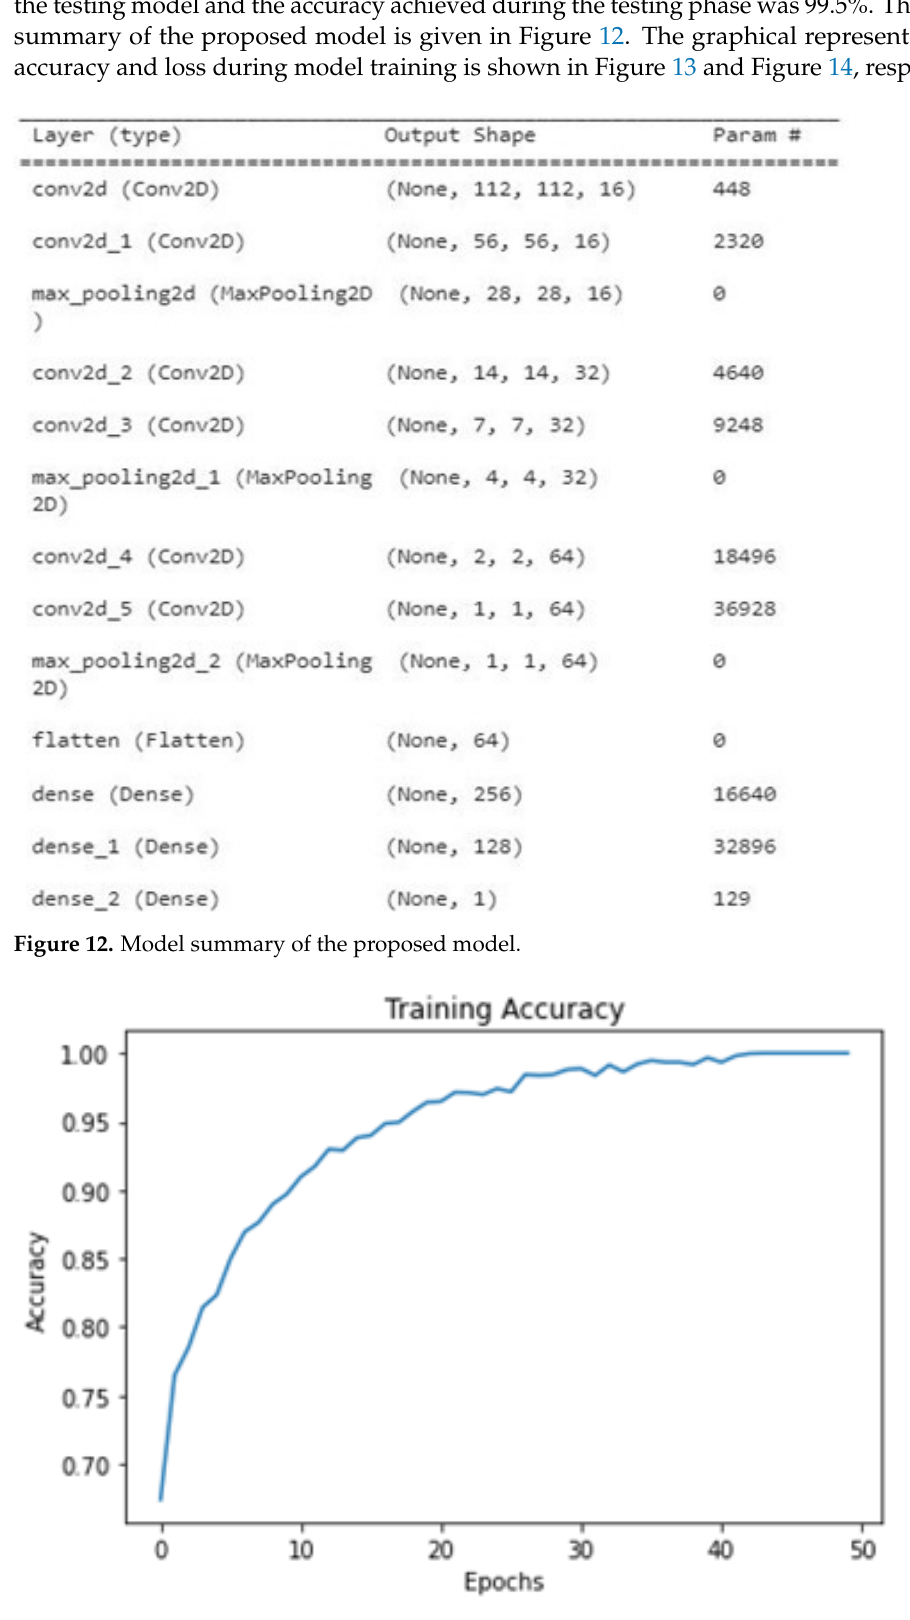
Figure 13. Training accuracy per